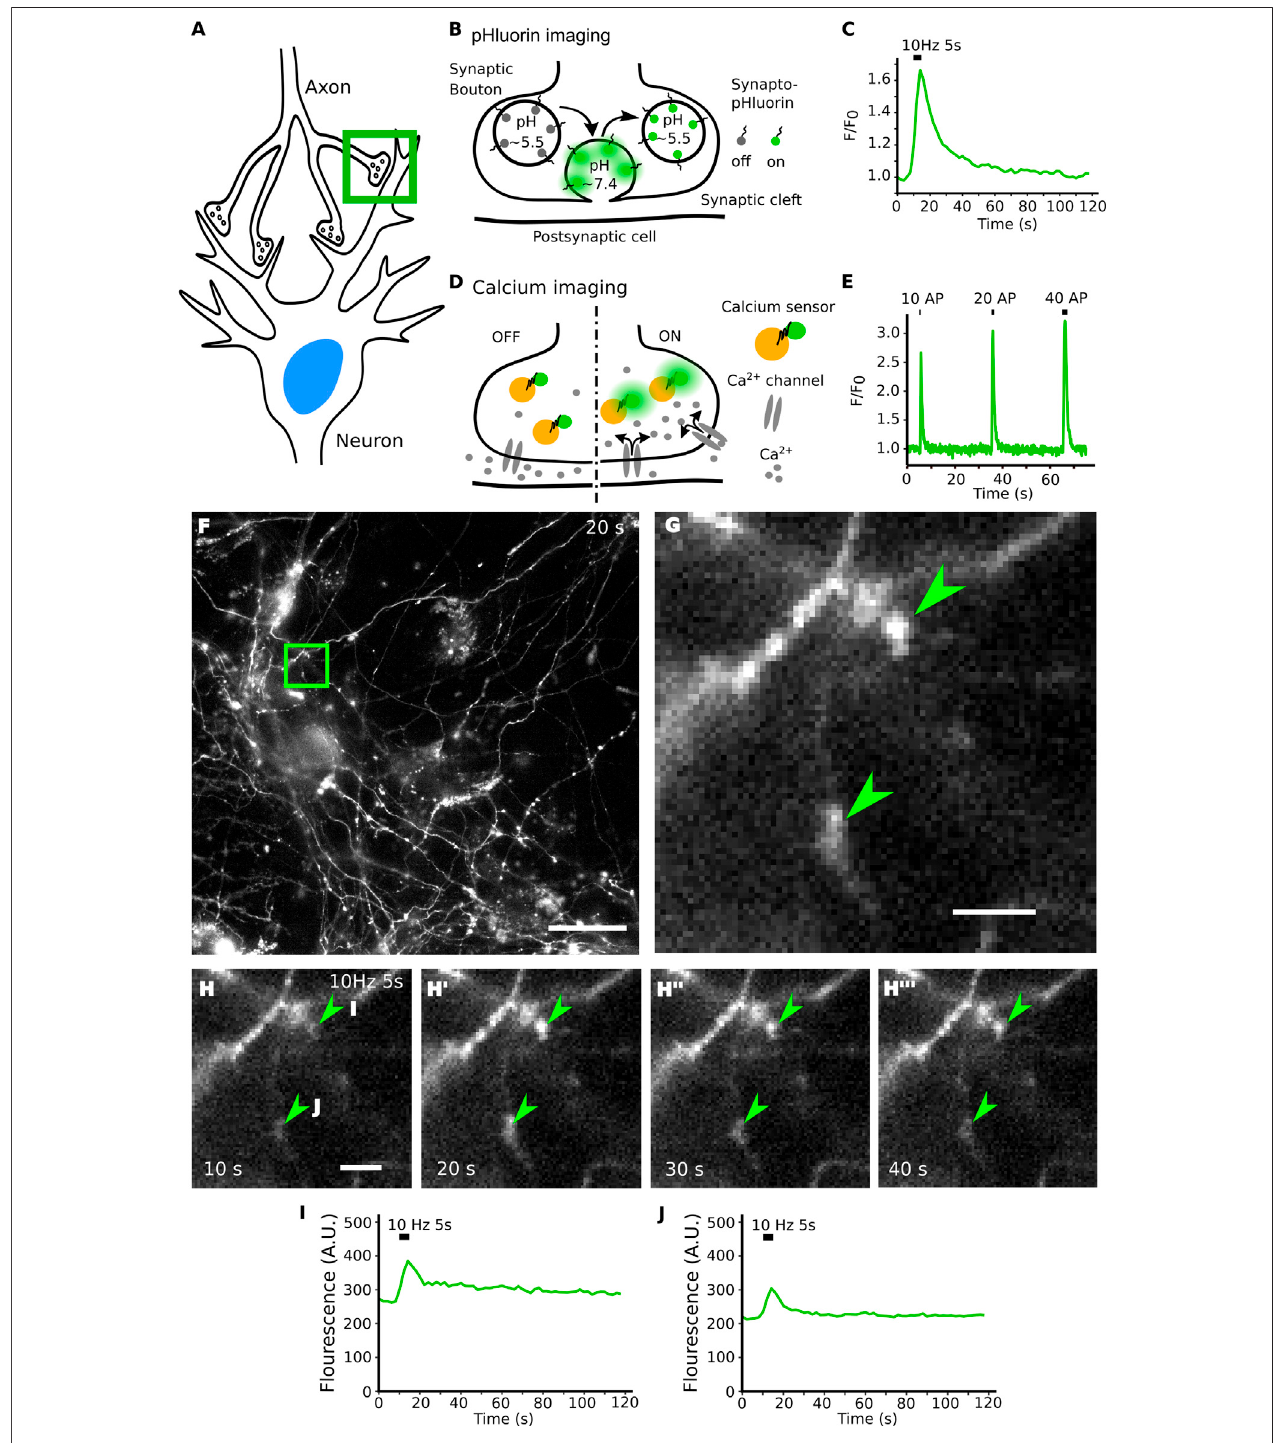
FIGURE 1 | Live imaging of synaptic activity. (A) Synaptic signal transmission between neurons depends on the function of synaptic vesicles and on the activity of ion channels. (B) Functional imaging by synapto-pHluorin allows studying synaptic vesicle exocytic fusion and subsequent endocytic recycling and acidi fi cation using a pH sensitive GFP genetically fused to the luminal domain of a synaptic vesicle membrane protein. The GFP fl uorescence is quenched under physiological steady-state conditionsintheacidicvesiclelumen. (B,C) UponfusionpHluorinisexposedtothehigherextracellularpH,becomes fl uorescentandisrapidlyquenchedwhenthe vesicle is endocytosed, and its lumen returns to its normal acidic pH. (D,E) The in fl ux of calcium elicits synaptic vesicle exocytosis and can be detected using calcium sensors. (F) A single frame from a full fi eld of view time-lapse movie of a hippocampal neuronal culture transfected with Synaptophysin-pHluorin. [ (G) , arrowheads]